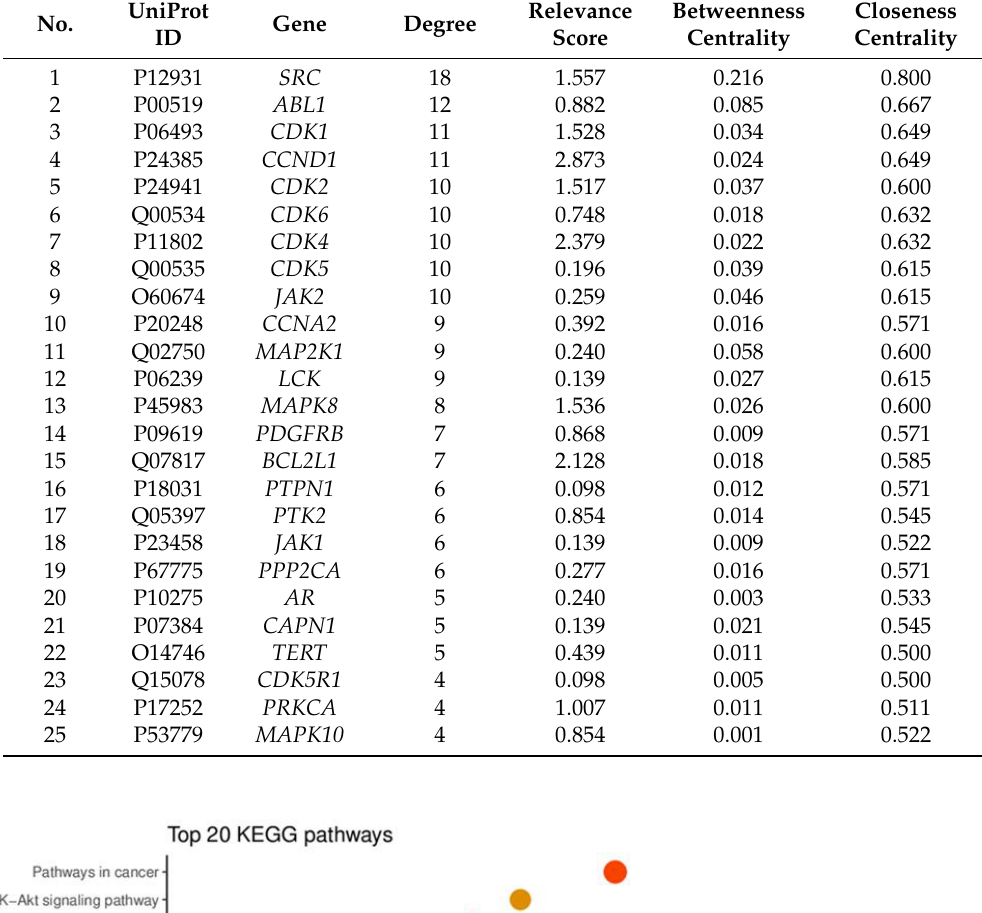
Table 2. A list of key targets based on protein–protein interaction network topological analysis.